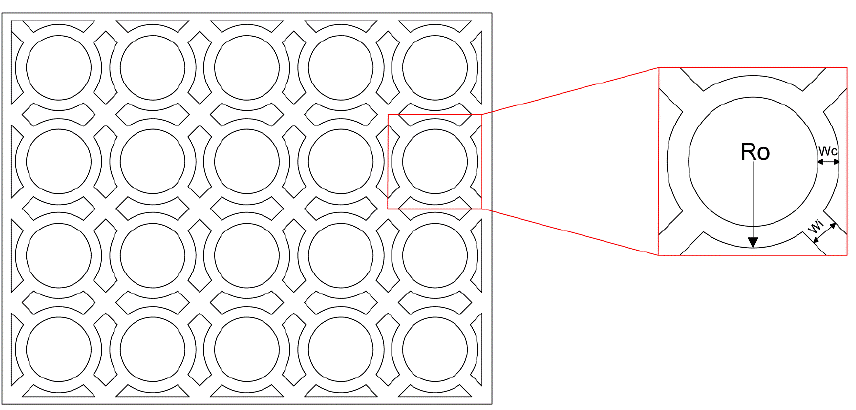
Table 3. Section Member Properties of Configuration 30.